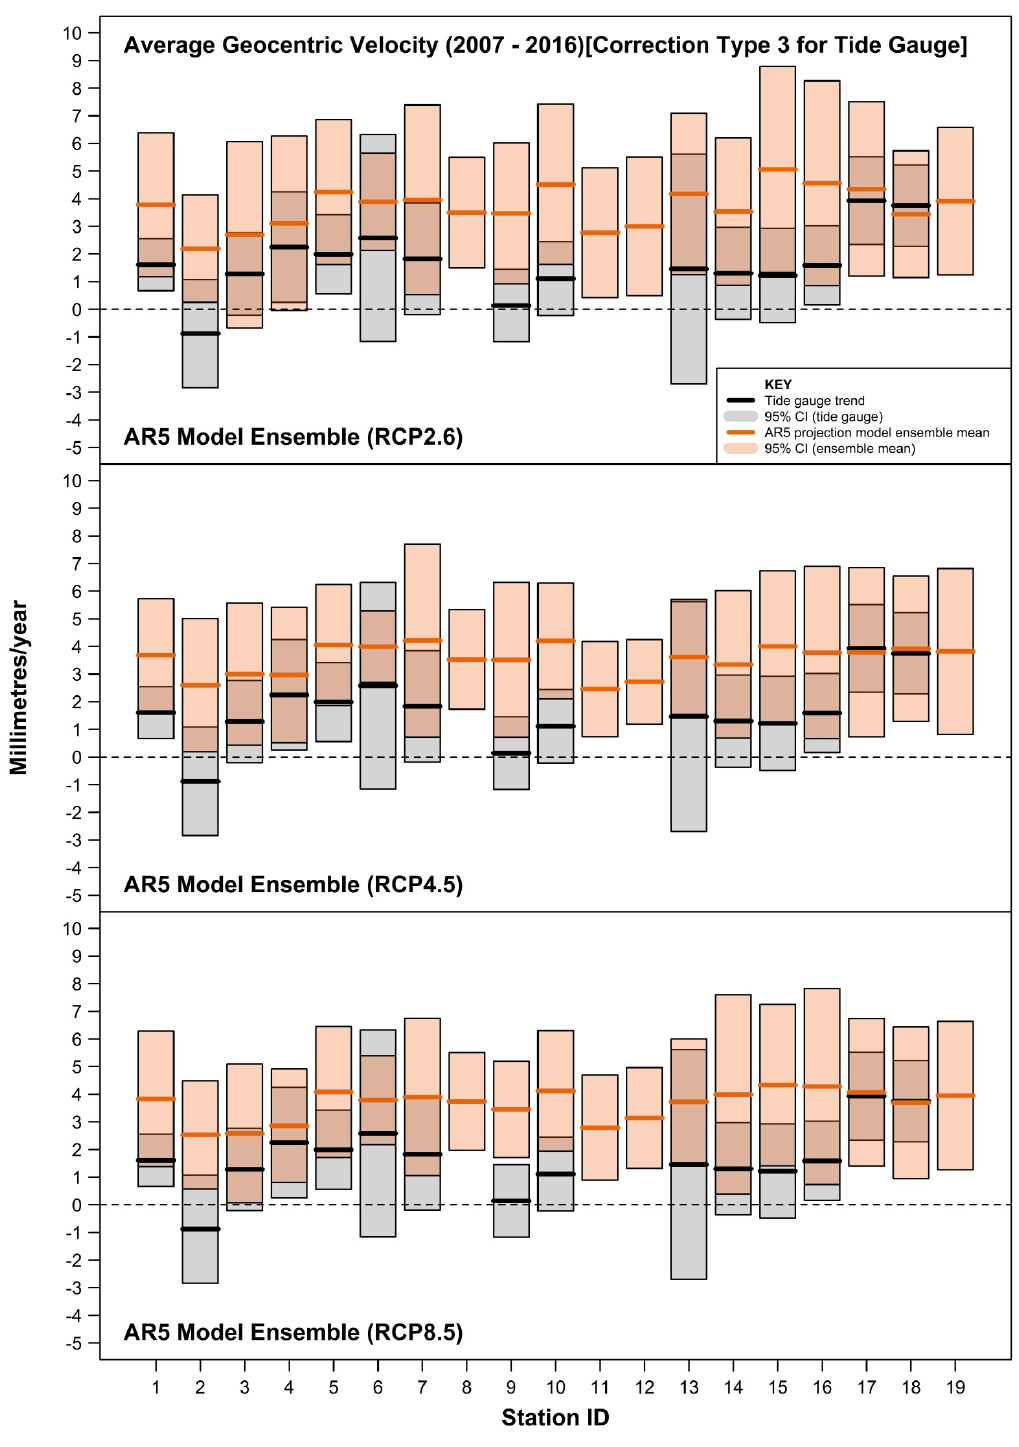
Figure 6. Average “geocentric” velocity determined over the period of common coverage (2007–2016) using Type 3 correction for VLM. Type 3 corrections are based on differences between altimetry and the tide-gauge record advised by Pfeffer and Allemand 2016 [32]. These charts directly compare the observational record (tide-gauge analysis) and corresponding AR5 ensemble-model projections at the grid point of interest. Refer to Figure 1 and Table 1 for station ID details.